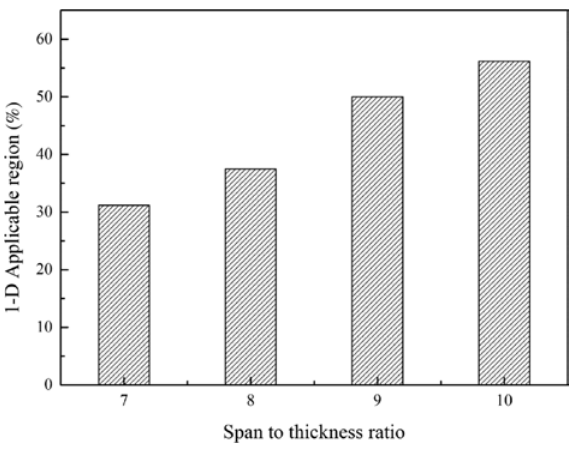
Figure 9: Percentage of 1-D analysis applicable